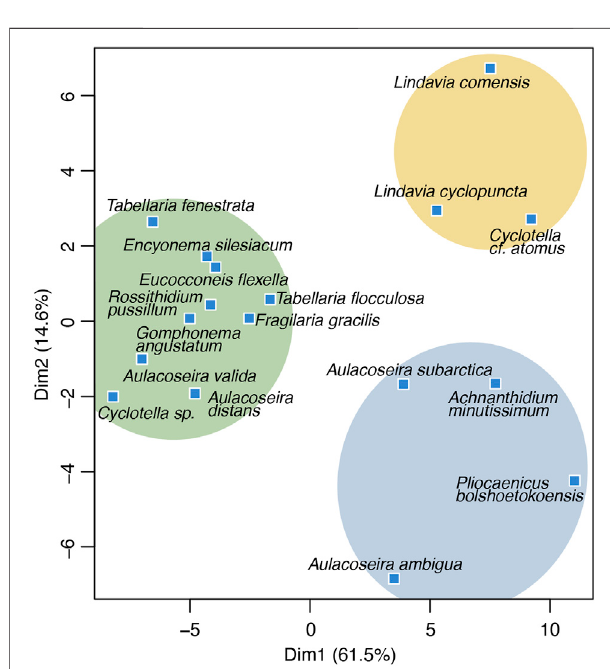
FIGURE6| Biplotofthe fi rsttwodimensions (Dim1,Dim2) generatedby multi-dimensional scaling (MDS) analysis of diatom species data. Colored circles indicate eco-taxonomical clusters with similar environmental preferences. Explained variance of each dimension is given at the axis